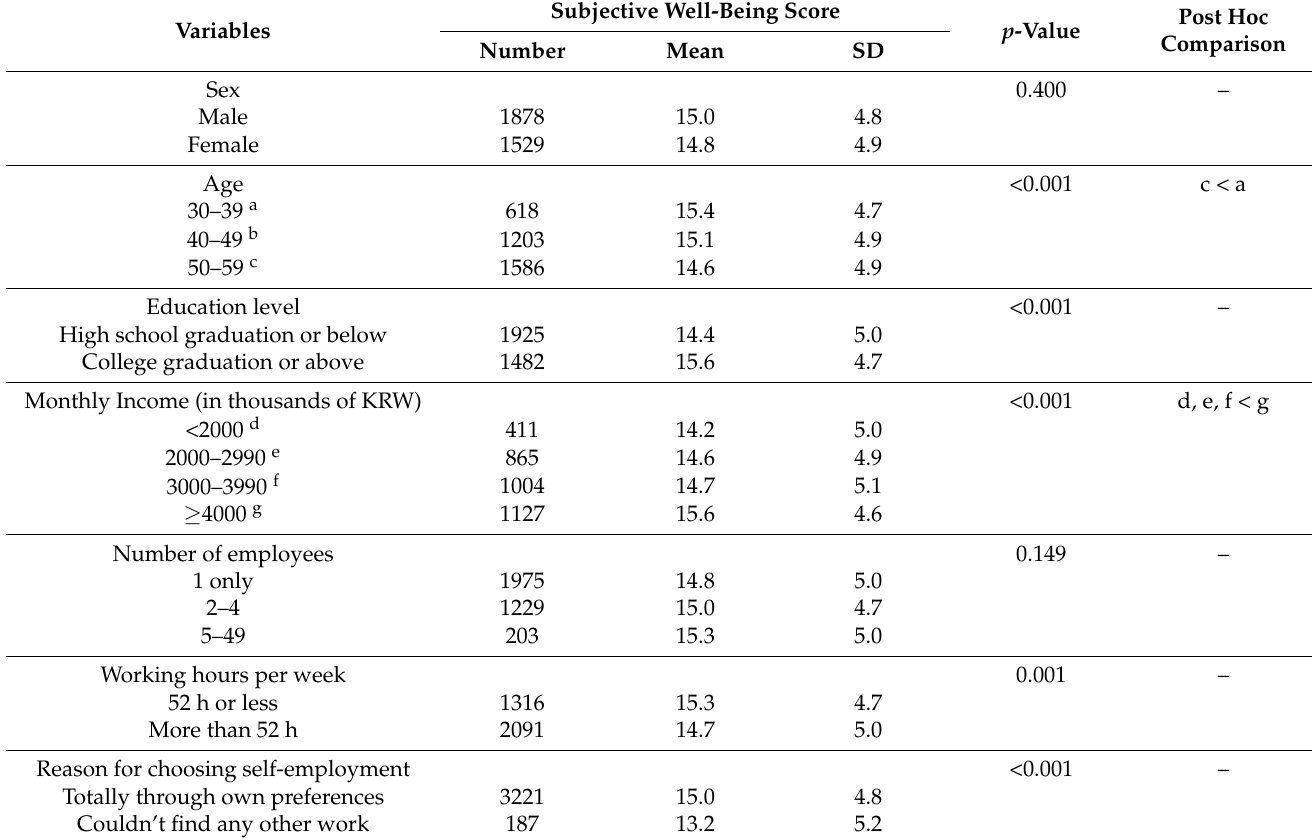
Table 1. General characteristics of the study populations and their subjective well-being score ( N =